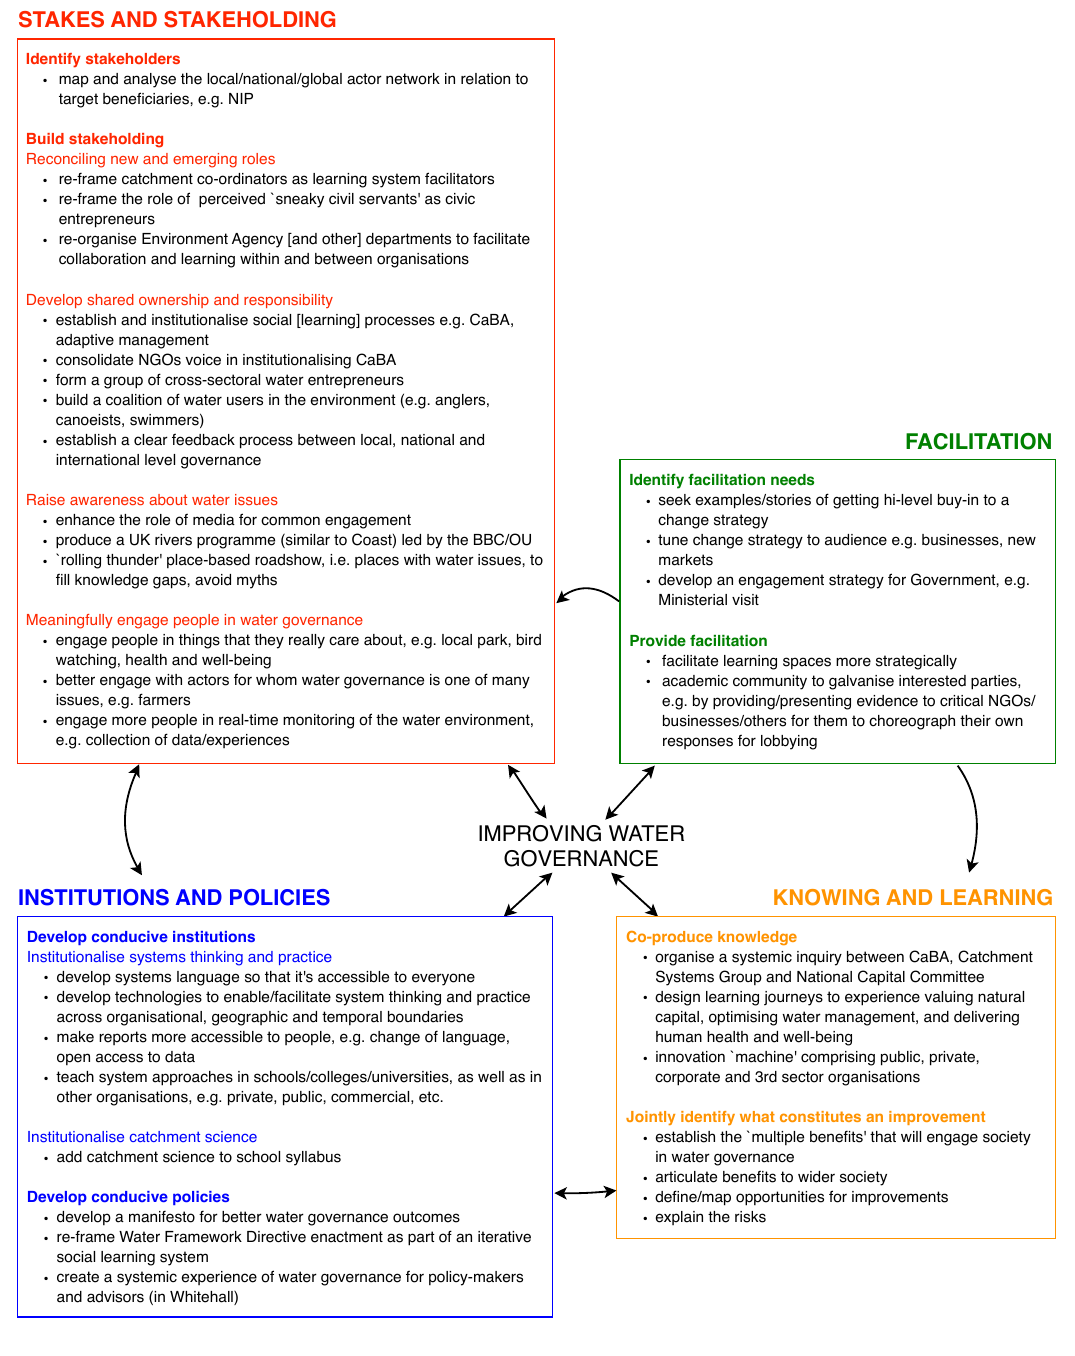
Figure 5. Actions to improve water governance in England (summarised and redrawn from the versions created at the workshop using an adapted version of a framework developed by Ison et al. [22])